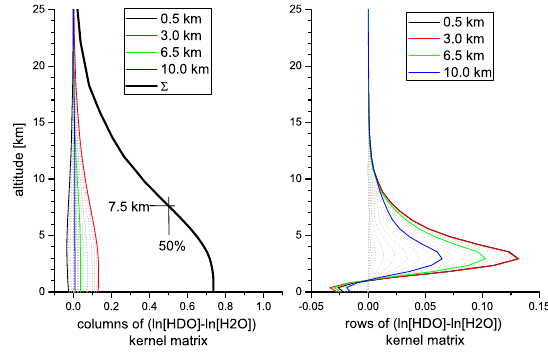
Fig. 3. Same as Fig. 2 but for ln[HDO] − ln[H 2 O] .